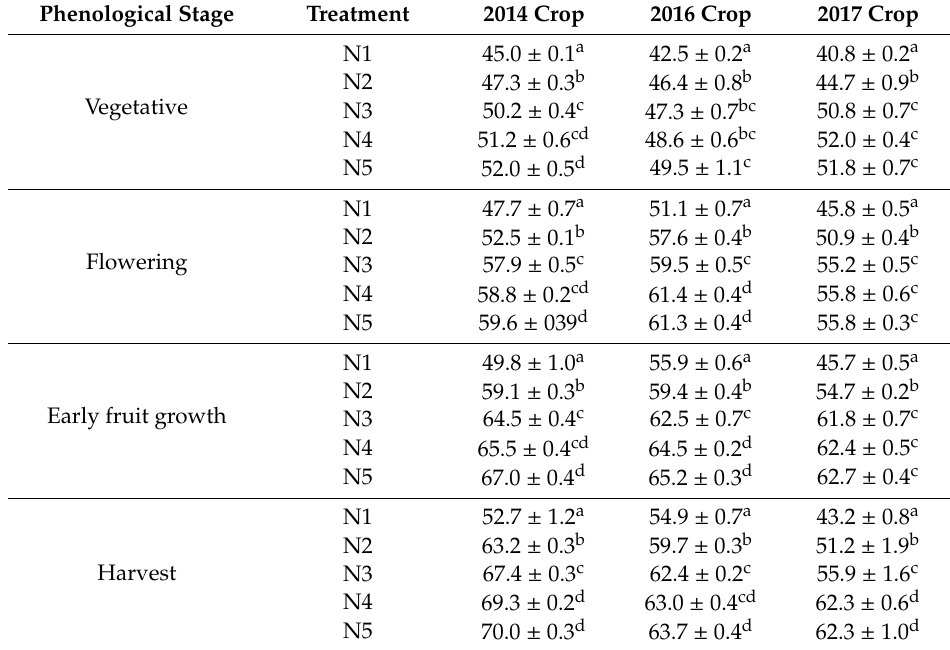
Table 3. Integrated SPAD ( SPADi ) values for each N treatment within each phenological stage in each of the three sweet pepper ( Capsicum annuum ) crops. Di ff erent lower-case letters (a–d) show significant di ff erences between N treatments within each phenological stage and crop, after LSD post-hoc test of ANOVA. p -value < 0.001. Values are means (n = 4) ± standard error (SE). Each crop was subjected to five di ff erent N treatments with four repetitions.